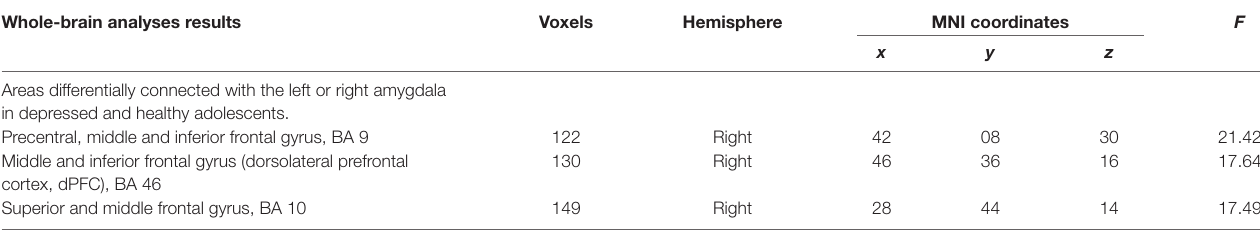
TABLE 2 | Connectivity with the amygdalae during the ESOM_NF task.